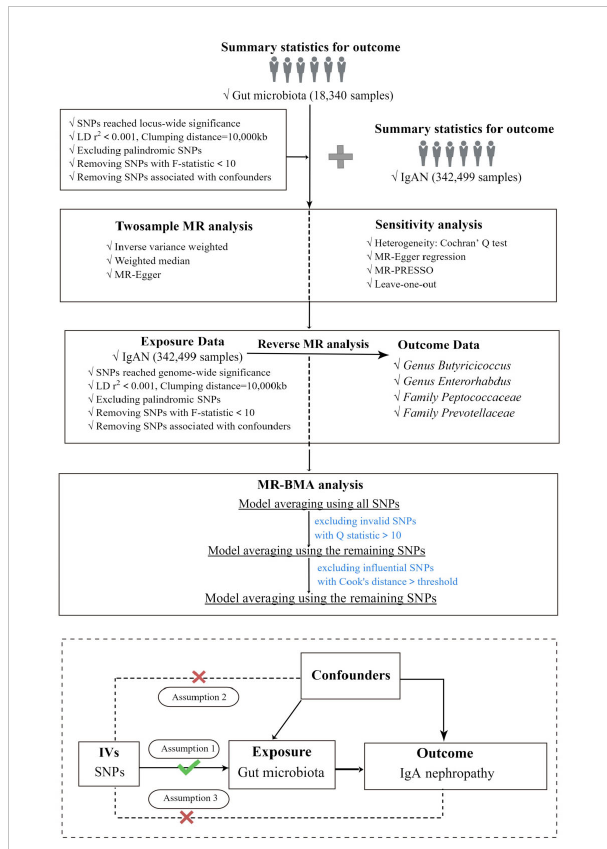
FIGURE 1 The study design and major assumptions of the Two-sample MR study. LD r 2 , r 2 in linkage disequilibrium; SNPs, single nucleotide polymorphisms; IgAN, IgA nephropathy; MR-PRESSO, Mendelian Randomization Pleiotropy RESidual Sum and Outlier; IV, instruments variable; MR-BMA, MR Bayesian Model